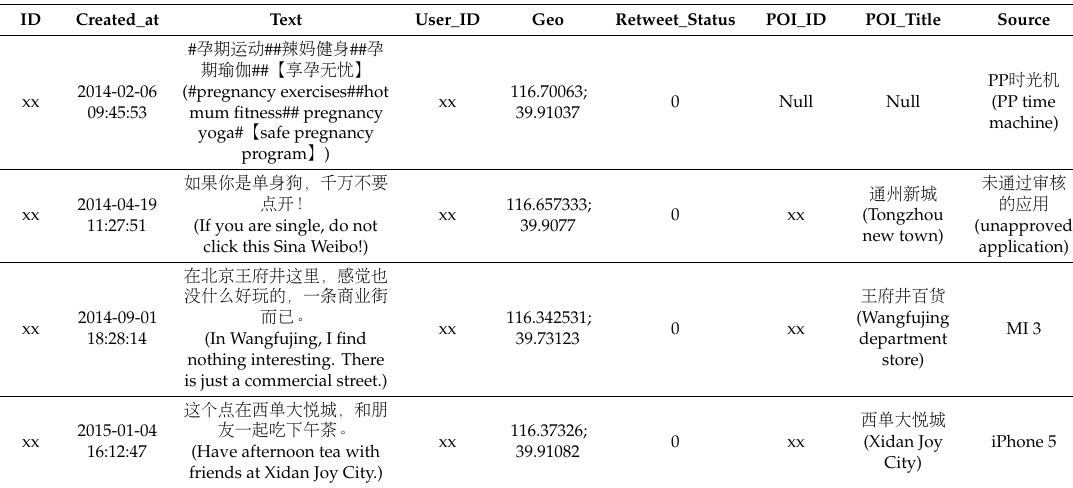
Table 1. Sina Weibo data samples.